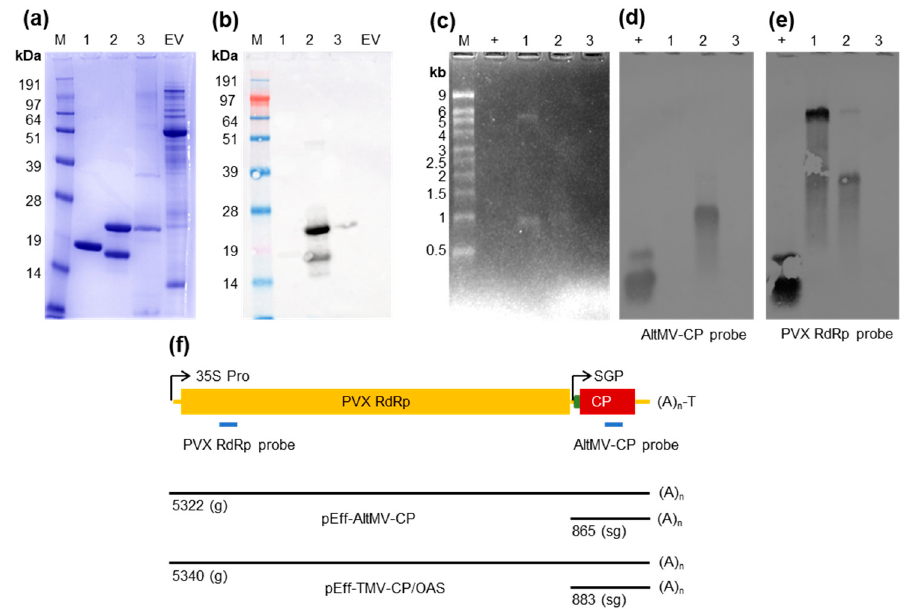
Figure 4. VLPs made with pEff package specific RNAs. VLPs were purified from three constructs: (1) pEff-TMV-CP/OAS; (2) pEff-AltMV-CP and (3) pEAQ- HT -AltMV-CP. Equal amounts of each particle preparation, as judged by protein content, were analyzed by Coomassie-stained SDS-PAGE ( a ) and anti-PapMV western blot ( b ). RNA was extracted from 50 µg of each preparation and run on duplicate agarose gels for Northern blotting. Ethidium bromide-stained RNA gel ( c ). Northern blots were probed with AltMV-CP probe ( d ) and PVX RdRp probe ( e ). Schematic diagram ( f ) showing genetic elements (relative lengths to scale), probe binding sites (blue) of pEff-AltMV-CP and PVX RdRp probes, and expected lengths of full-length ‘genomic’ RNA (g) and subgenomic RNA (sg). M: marker; EV: empty vector control clarified extract; +: positive control PCR product (DNA) of AltMV-CP or PVX Rep containing probe binding site.